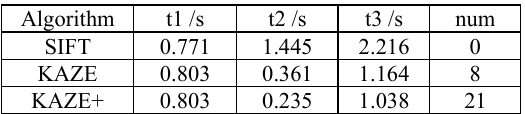
Table 2. The matching result of IRS-P5 image(434*379) and